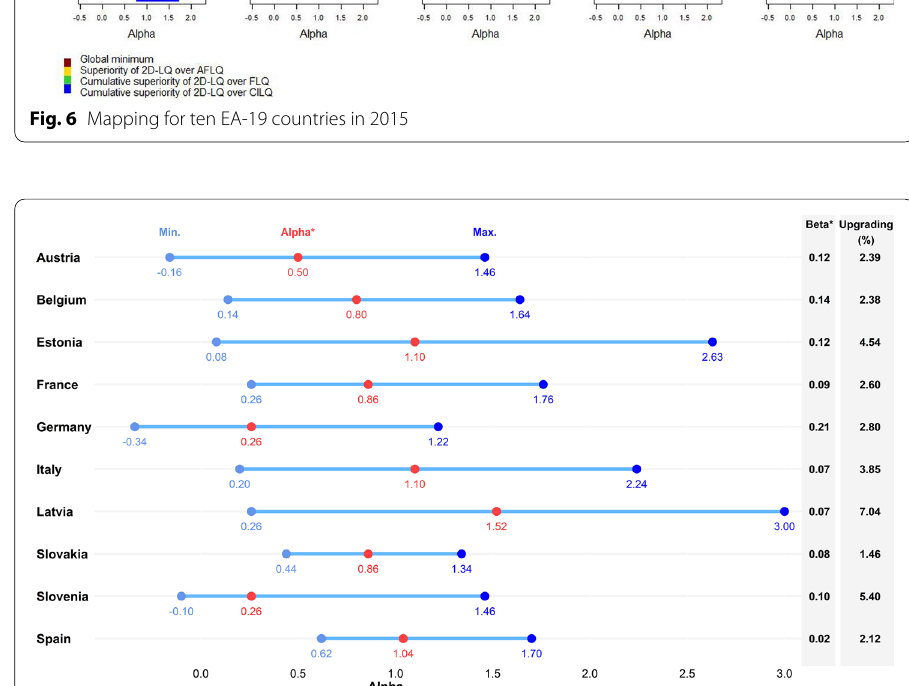
Fig. 7 Superiority of 2D‑LQ front AFLQ ( δ *): width of the α range in